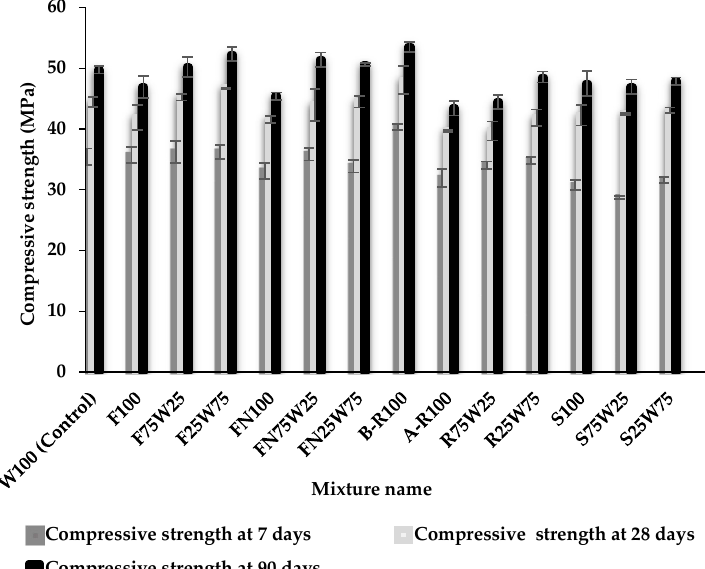
Figure 3. Compressive strength of concrete specimens at 7, 28, and 90 days curing time. Well water was used as mixing water in control specimen. Each data point was measured in triplicate and the error bar stand for standard deviation.